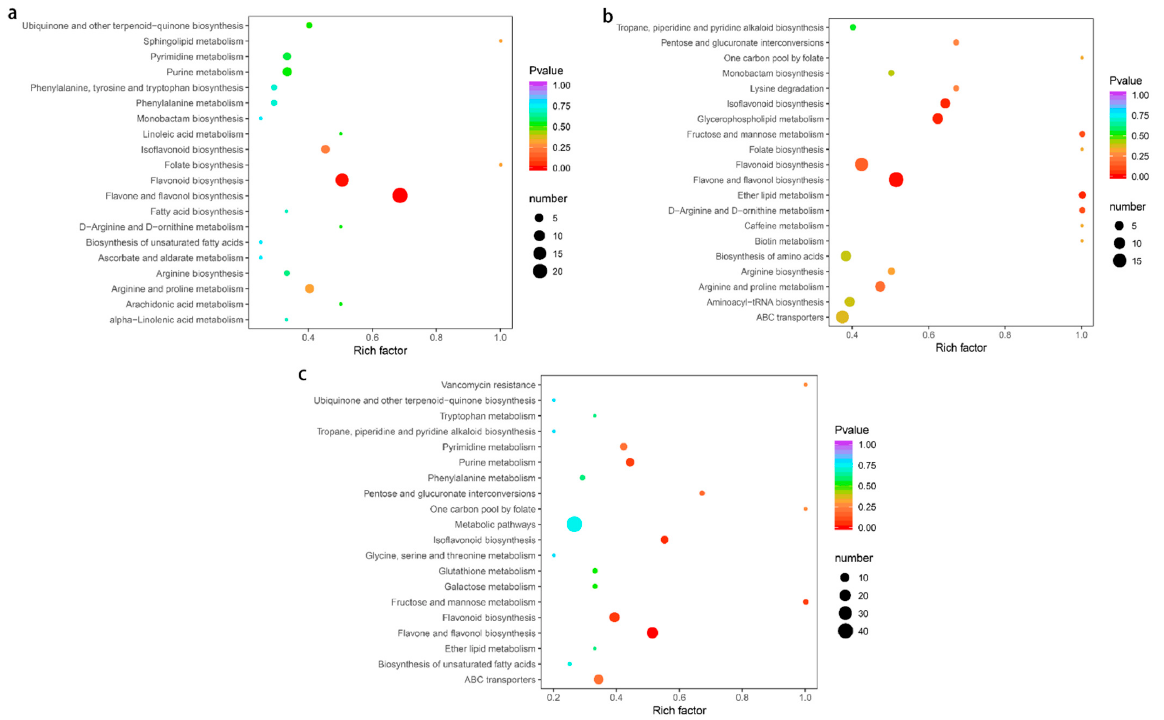
Figure 9. KEGG enrichment maps of differential metabolites: ( a ) RS vs. GP; ( b ) GP vs. ZJ; ( c ) ZJ vs. RS. The abscissa represents the enrichment factor of the pathway, and the ordinate shows the names of pathways. The color of the dot represents the p -value, and the deeper the red of the dot, the stronger the enrichment effects. The size of points represents the number of metabolites enriched in the pathways.